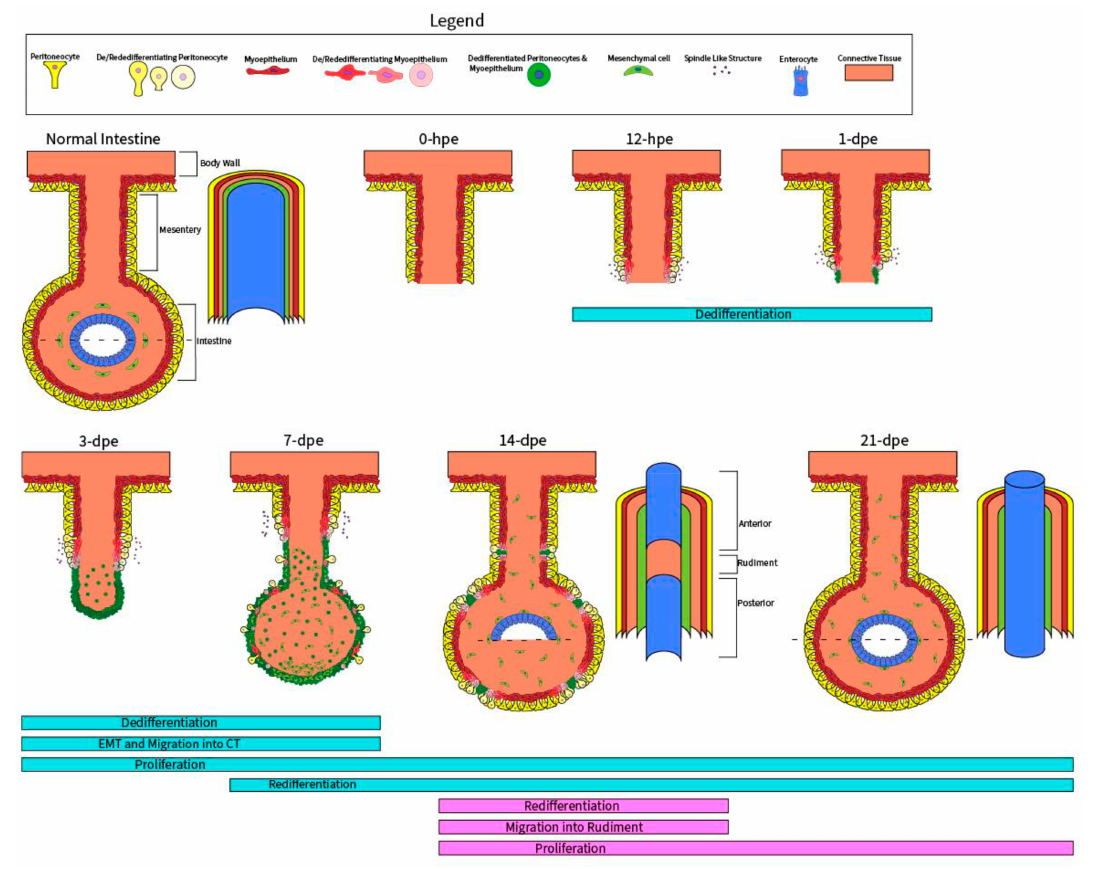
Figure 1. The process of intestinal organogenesis after evisceration. Beneath each timepoint is a color- coded cellular process unique to either the mesothelium (light blue) or luminal epithelium (dark pink). Normal Intestine: a normal intestine connected to the body wall with the mesentery and intestine distinguished, which are the controls for the rudiment and lumen, respectively. 0-hpe: the eviscerated intestine leaves a torn edge at the mesenterial tip, which is the site of injury response and initial wound healing, thus beginning the process of regeneration. 12-hpe: dedifferentiation occurs in the mesothelium, which is composed of peritoneocytes and myoepithelium; this process is characterized by the presence of spindle like structures that are discarded actin filaments from myoepithelial cells. 1-dpe: dedifferentiation of the mesothelium continues in a gradient along the mesentery, moving proximally toward the body wall. 3-dpe: some dedifferentiated cells ingress into the connective tissue (CT) of the rudiment, undergoing an epithelial-to-mesenchymal transition (EMT). 7-dpe: proliferation in the regenerating rudiment picks up pace; simultaneously, a few cells begin redifferentiating into mature mesothelium. 14-dpe: the rudiment is invaded by luminal epithelium derived from the esophagus (anterior) and the cloaca (posterior) that extend toward one another. The dashed line shows the anterior and posterior intestine with luminal epithelium and a surrounding mesenchyme (above dash), while in between is the rudiment without a lumen (below dash). 21-dpe: the